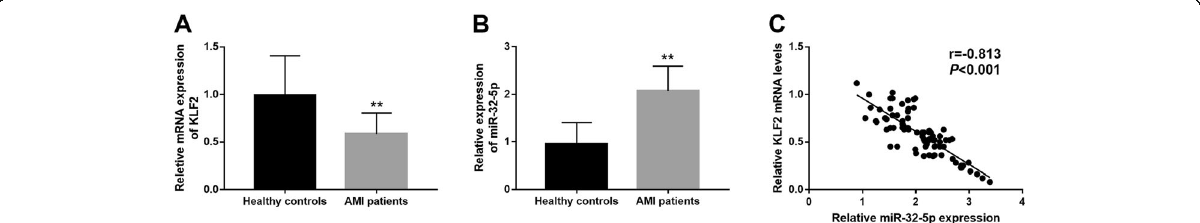
Fig. 2 Serum expression of KLF2 and miR-32-5p in patients with AMI. a . Serum mRNA expression of KLF2 was decreased in AMI patients compared with the healthy controls. b . Serum miR-32-5p expression was higher in AMI patients than that in the healthy controls. c . Serum miR- 32-5p levels were negatively correlated with serum mRNA levels of KLF2 ( r = − 0.813, P < 0.001). ** P < 0.01